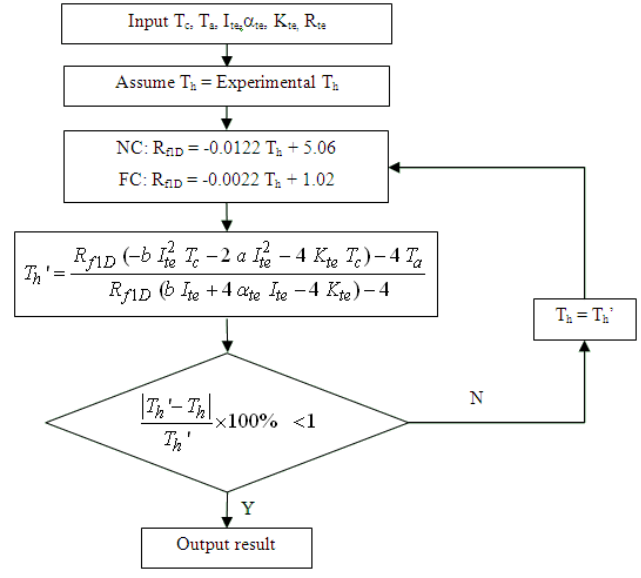
Figure 4. Flowchart to simulate the TE hot side ( T h ) temperature.